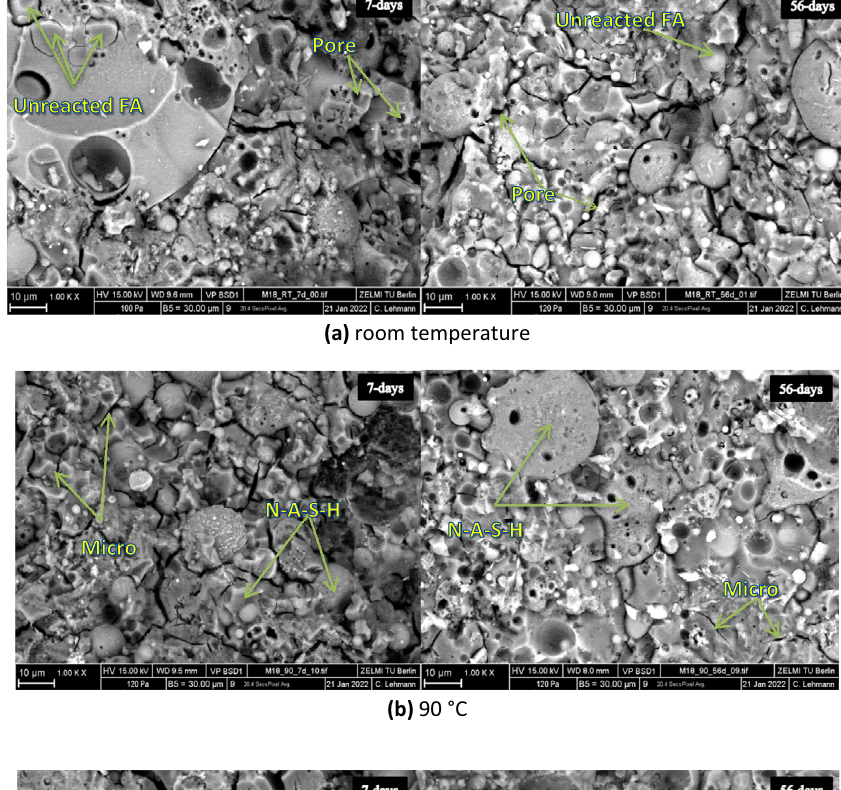
Fig. 12 SEM micrographs of MK9_20 at ages of 7 and 56 days at temperatures a room temp., b 90 °C, c 300 °C and d 500